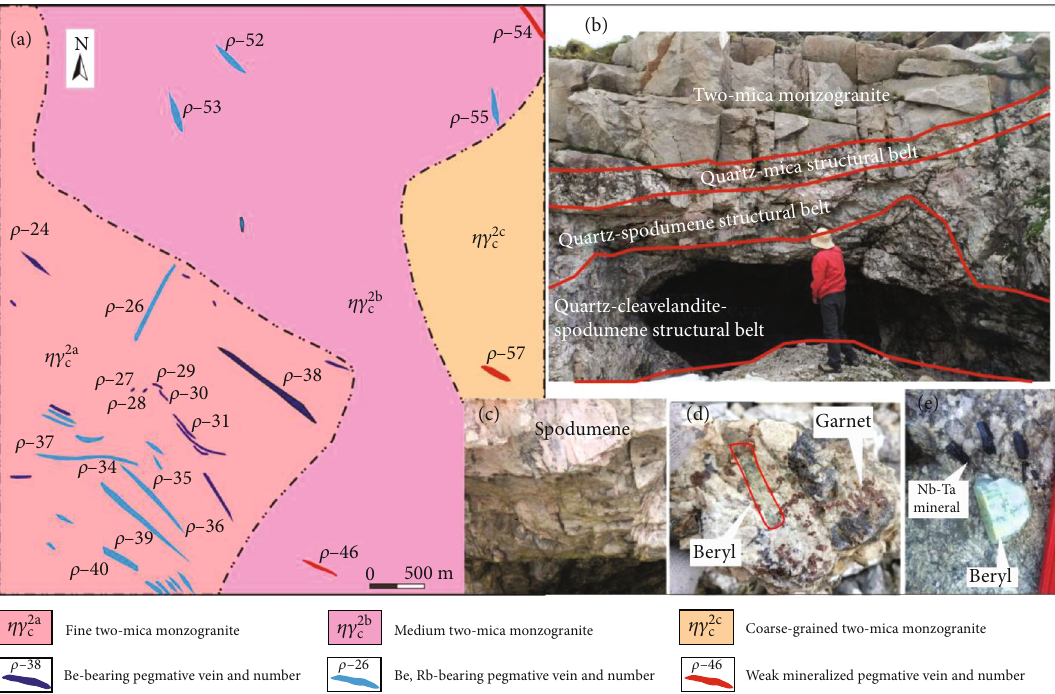
Figure 8: Pegmatite dyke distribution map (a, b) of Bieyesamas mining area and mineral occurrence characteristics (c – e) (after